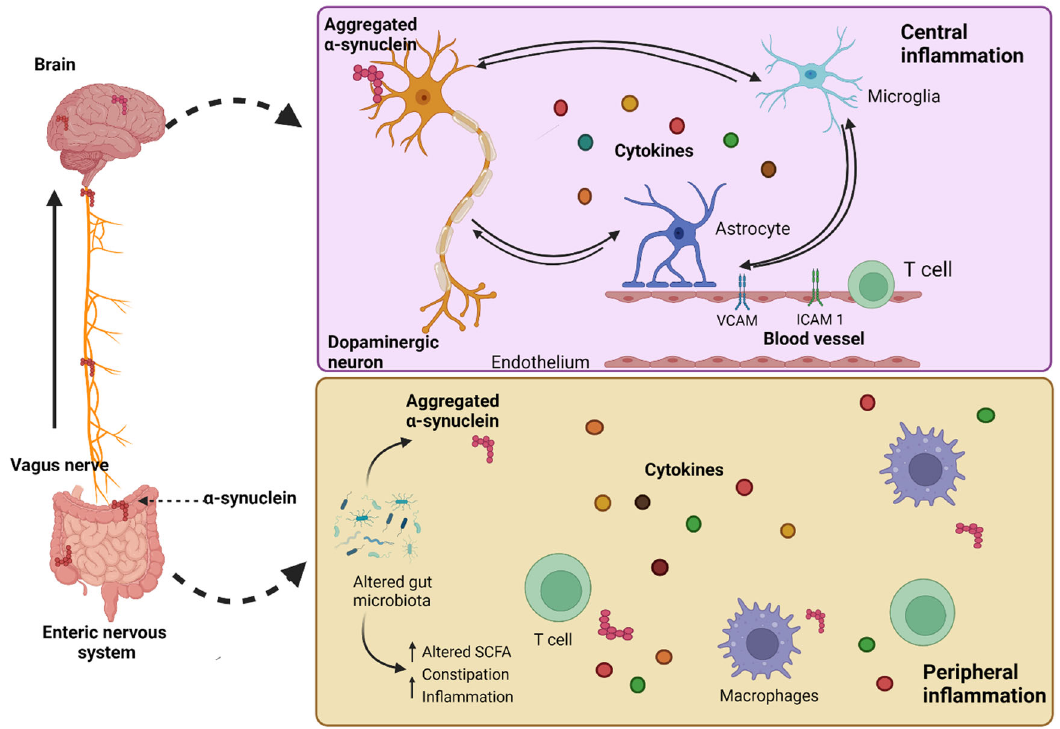
Fig. 4 Gut-brain microbiome interaction 207 . Changes inside the intestinal microbiome might encourage α -synuclein accumulation as well as cause an in fl ammatory reaction inside the periphery. This may include elevated cytokine production and activation of T cells, according to the “ gut-brain axis ” concept in PD. Aggregation of α -synuclein is thought to propagate in a prion-like way initially from the peripheral to the central nervous system via the vagus nerve. When it enters the brain, proteinopathy, in combination with many invoking variables like mitochondrial impairment, ROS, etc., would then endure core in fl ammatory response inside a vicious spiral among dropping dead dopamine neuronal cells, glia, and activated endothelium. This will in turn get exacerbated by intruding peripheral immune cells. SCFA: Short-chain fatty acids, VCAM: Vascular Cell Adhesion Molecule, ICAM1: Intercellular Adhesion Molecule